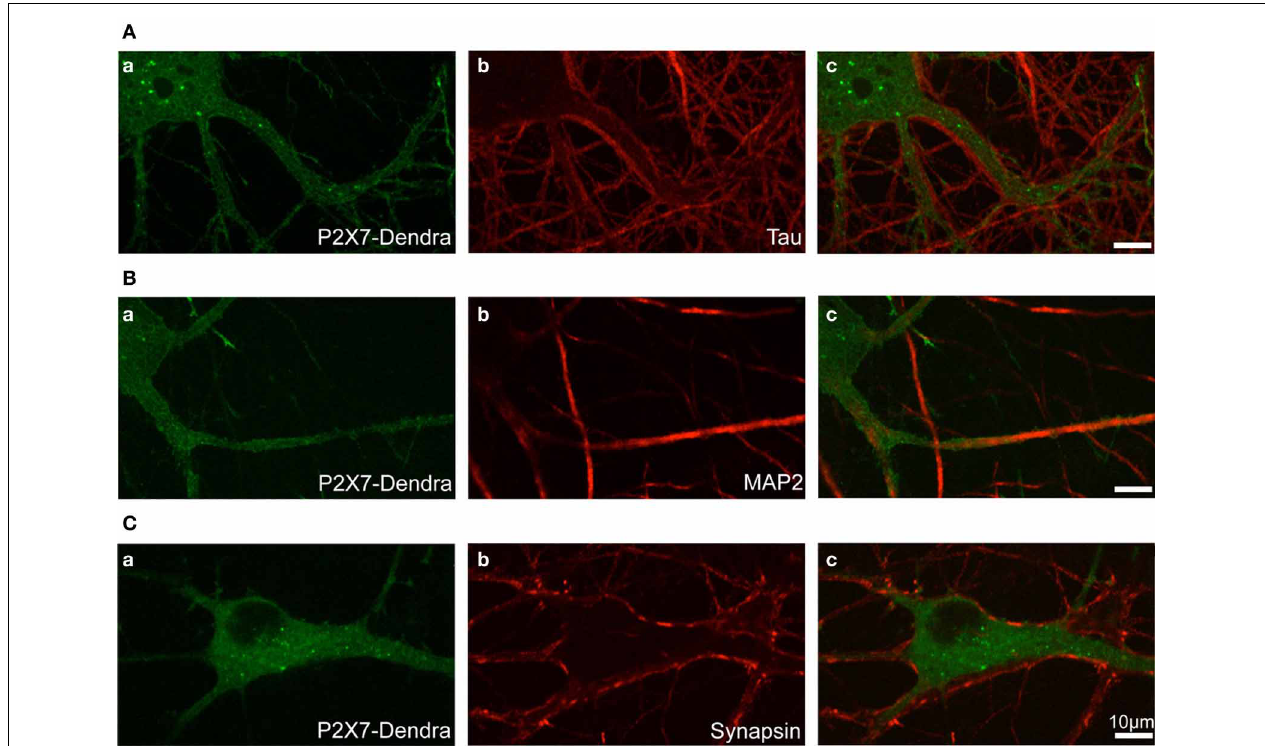
FIGURE 1 | Localization of transfected P2X7-Dendra2 receptors in dendrites. Dendra2-tagged P2X7Rs were transfected in hippocampal neurons at DIV 12. Forty-eight hours after transfection, immunocytochemistry was performed to determine the localization of P2X7Rs. (Aa,Ba,Ca) Diffused labeling of P2X7Rs with expression in cell body and neurites can be